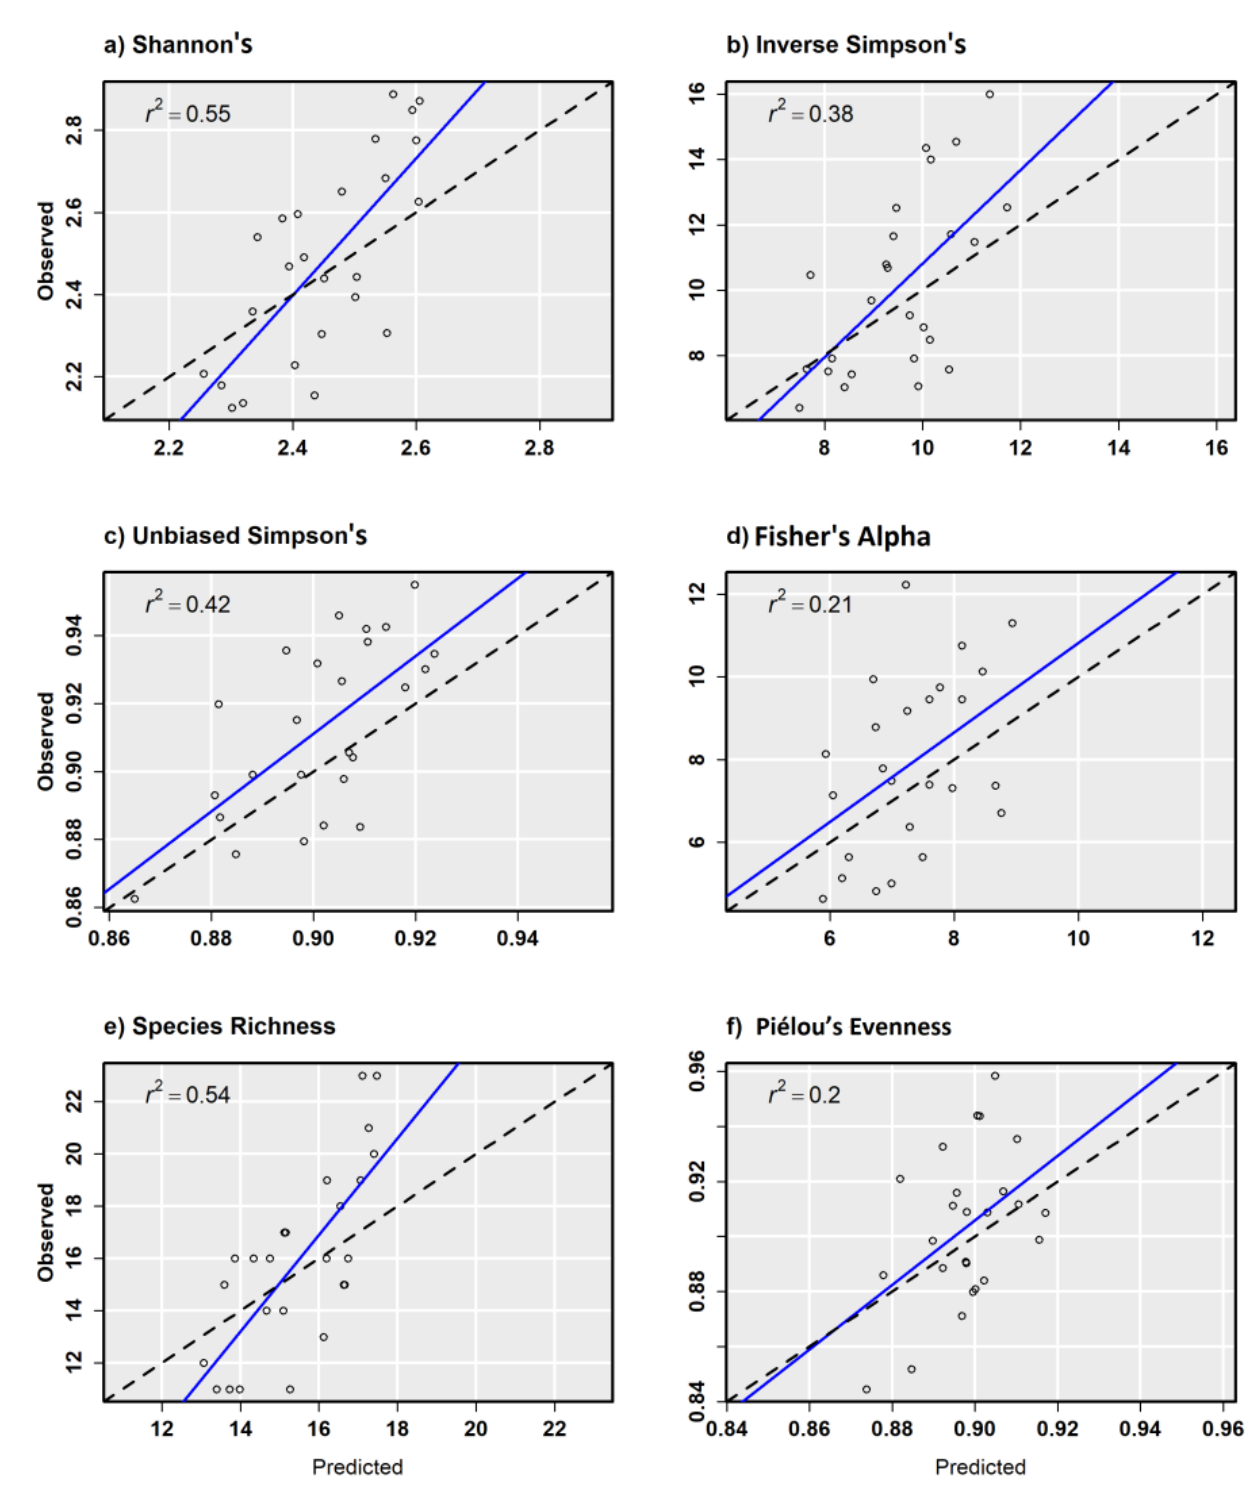
Figure 7. Observed versus predicted diversity index values for 10th ha regular validation plots from the combined ensemble models using Sentienl-2, RapidEye, and canopy height and topography predictor variables.